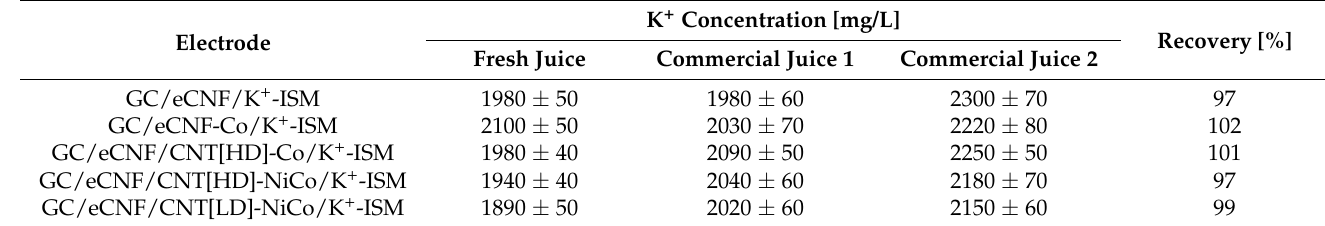
Table 3. Determination of K+ in different samples (SD of 3